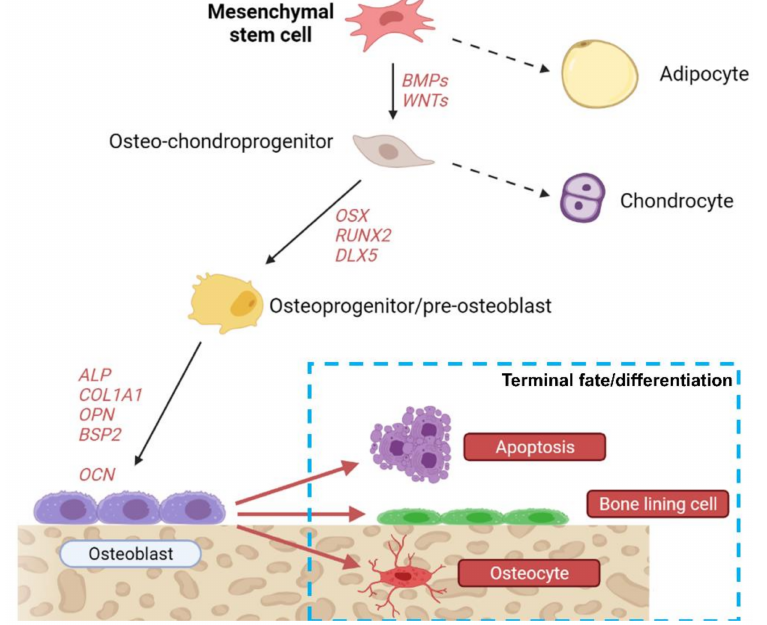
Figure 2. MSC differentiation. Cartoon showing the possible differentiation fates of mesenchymal stem cells. Created with